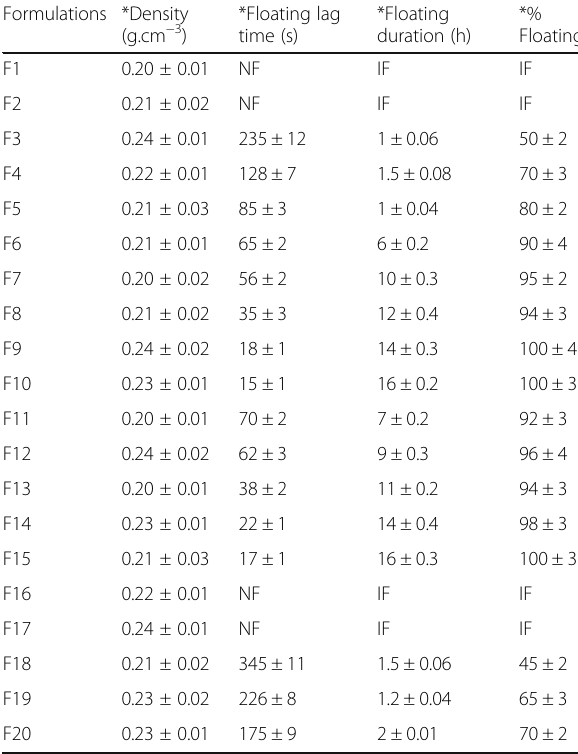
Table 3 Micromertics properties of solid dispersions Formulations *Angle of repose ( 0